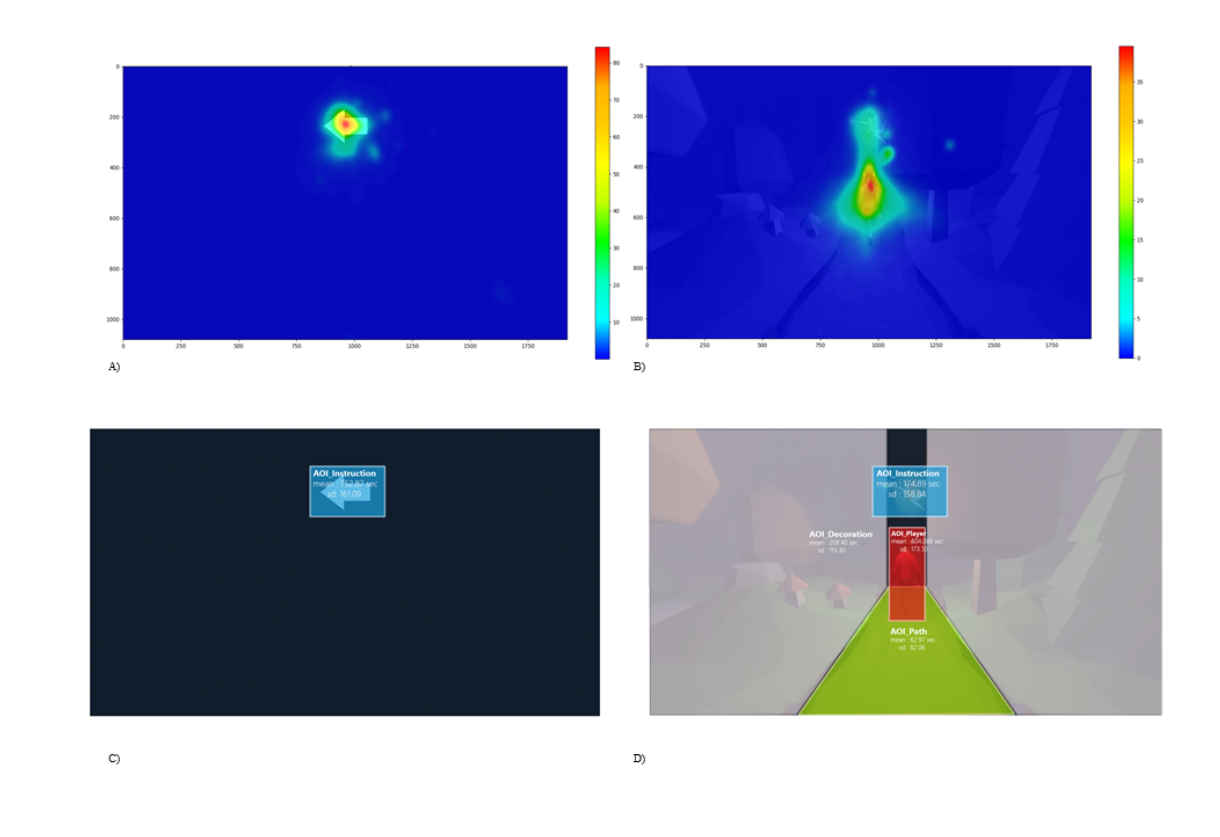
Figure 5. Visualization of the eye-tracking results. Parts (A) and (B) display the gaze focus as a heat map. Parts (C) and (D) display the mean time that the participants spent focused on parts of the display.